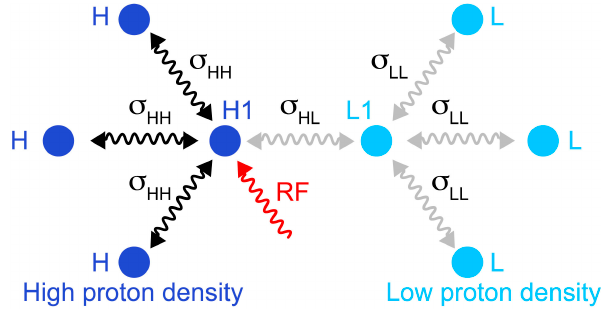
Figure 2. Schematic representation of the simulated spin system, which comprises four protons in a fully protonated protein ( left ) and four protons in a reduced proton density protein ( right ). The cross-relaxation rates within the high proton density are σ HH = 3 s − 1 ; cross-relaxation rates involving low proton density sites are σ HL = σ LL = 0.5 s − 1 . Longitudinal relaxation rates are R 1 (H1) = 12 s − 1 ; R 1 (H) = 10 s − 1 ; R 1 (L1) = 4 s − 1 ; R 1 (L) = 3.5 s − 1 . The transverse relaxation rate of the irradiated proton was R 2 (H1) = 25 s − 1 . The selective saturation was simulated following exactly the parameters presented in Figure 1: Gaussian shaped inversion pulses with a 12 ms duration were applied with a delay τ sat is 9 ms, and n was 115.